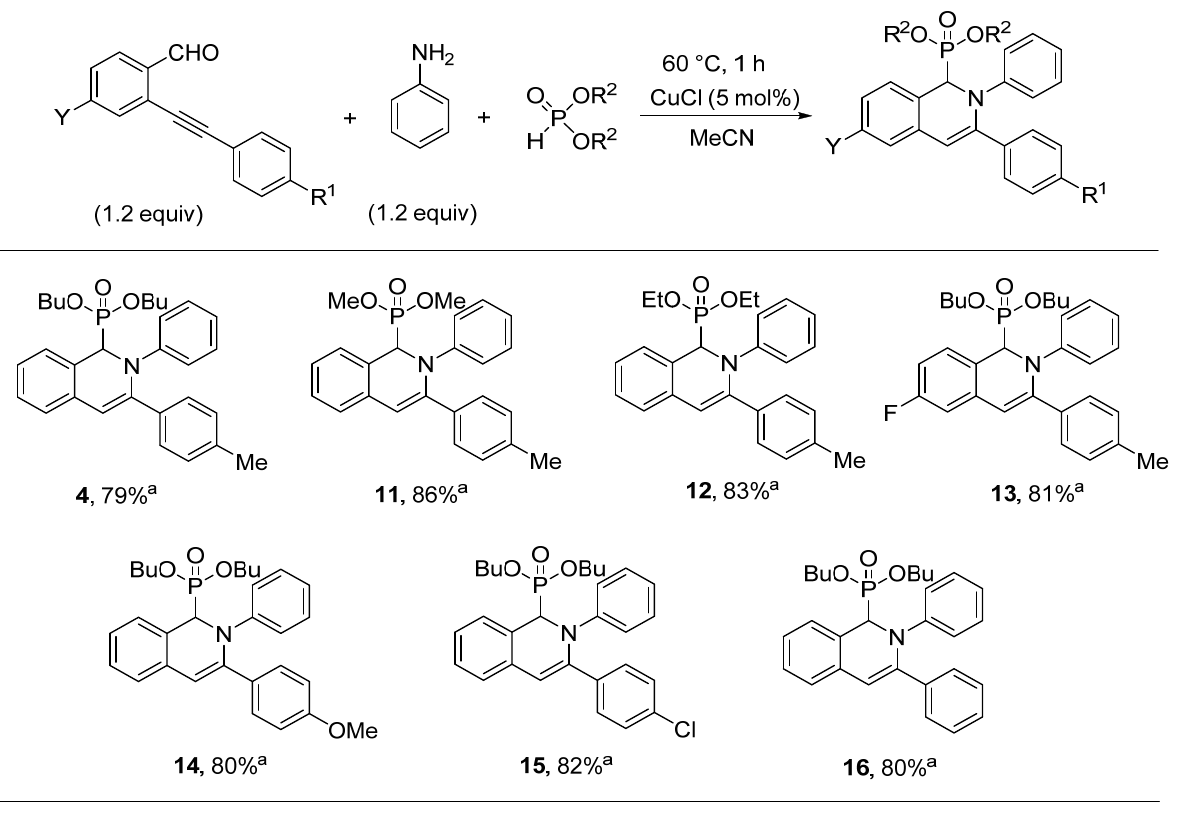
Figure 3. CuCl-catalyzed condensation of 2-alkynylbenzaldehydes, aniline, and dialkyl phosphites.